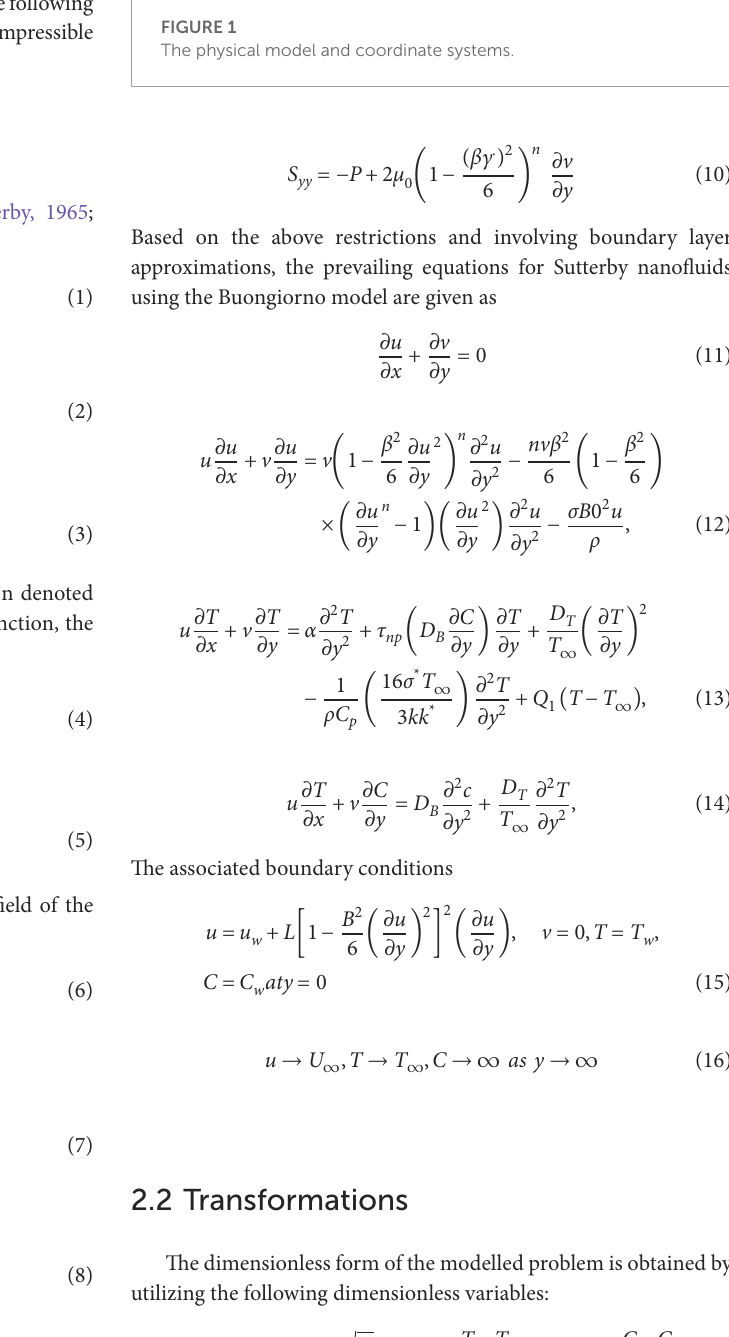
FIGURE 1 The physical model and coordinate